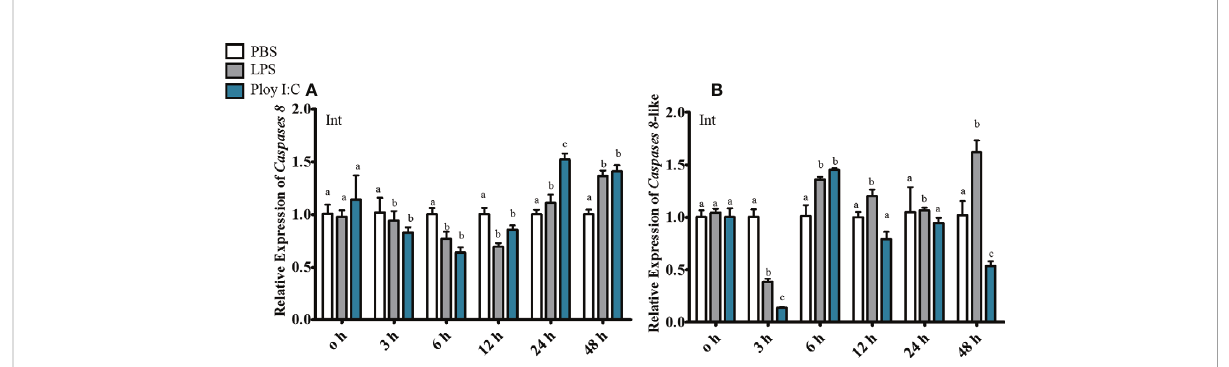
FIGURE 7 Real-time quantitative PCR was performed to detect cas8 [ (A) , Tocas8 ; (B) , Tocas8 -like) mRNA expression levels in intestine after LPS and Poly (I:C) stimulation. b -actin was selected as an internal reference gene to calibrate cDNA template. These values are presented as mean ± standard deviation (n =